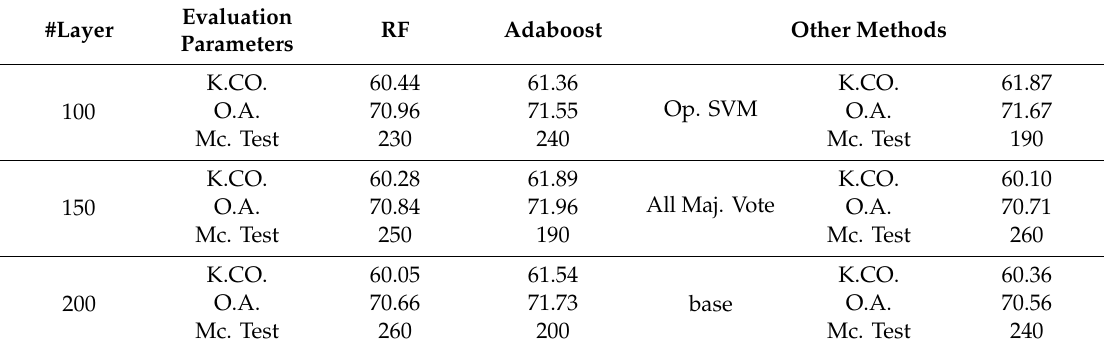
Table 6. Results of the implementation of comparative methods in terms of the type of features